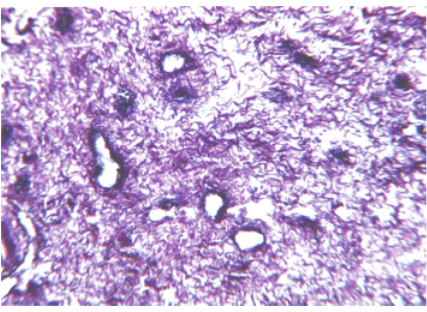
Figure 4: Argyrophilic fibers are preserved only around major structures on the background of necrotic changes in the pancreas. Gomori staining ( ×